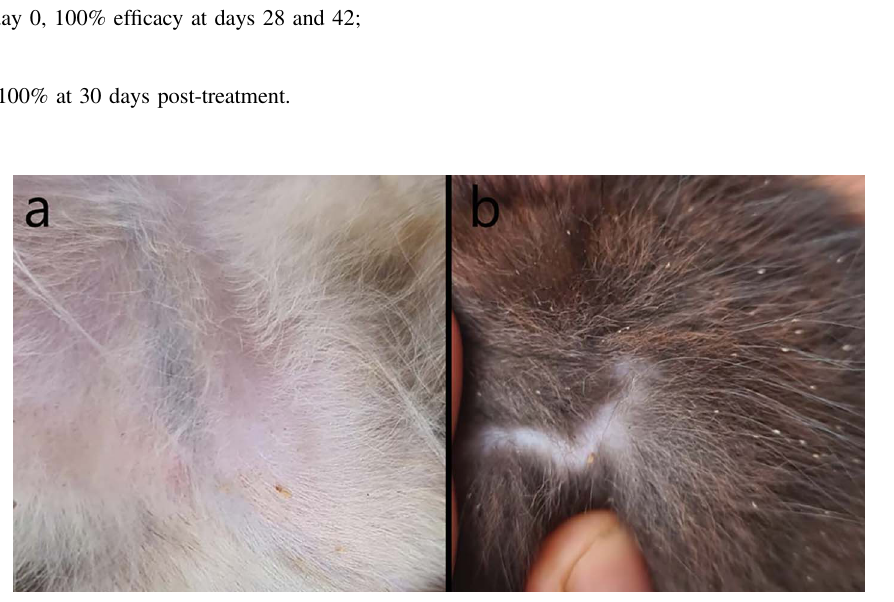
Figure 1. Infestation with Felicola subrostratus in domestic cats. (a) Note the adult louse; (b) presence of adult louse and nits.